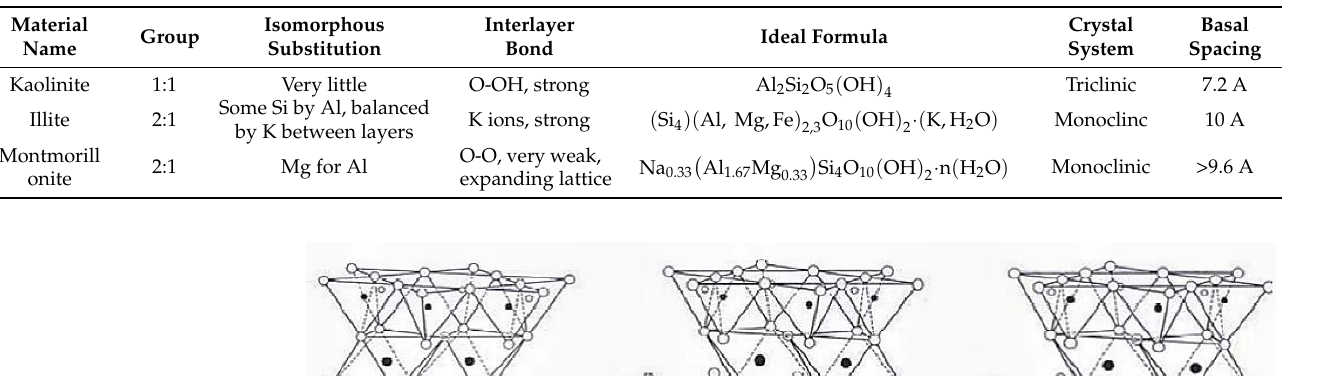
5 Table 2. Characteristics of kaolinite, illite, and montmorillonite. Reprinted with permission from Ref. [4]. Copyright: 2013, Mathieu Antoni. Published by Swiss Federal Institute of Technology Lausanne. Material